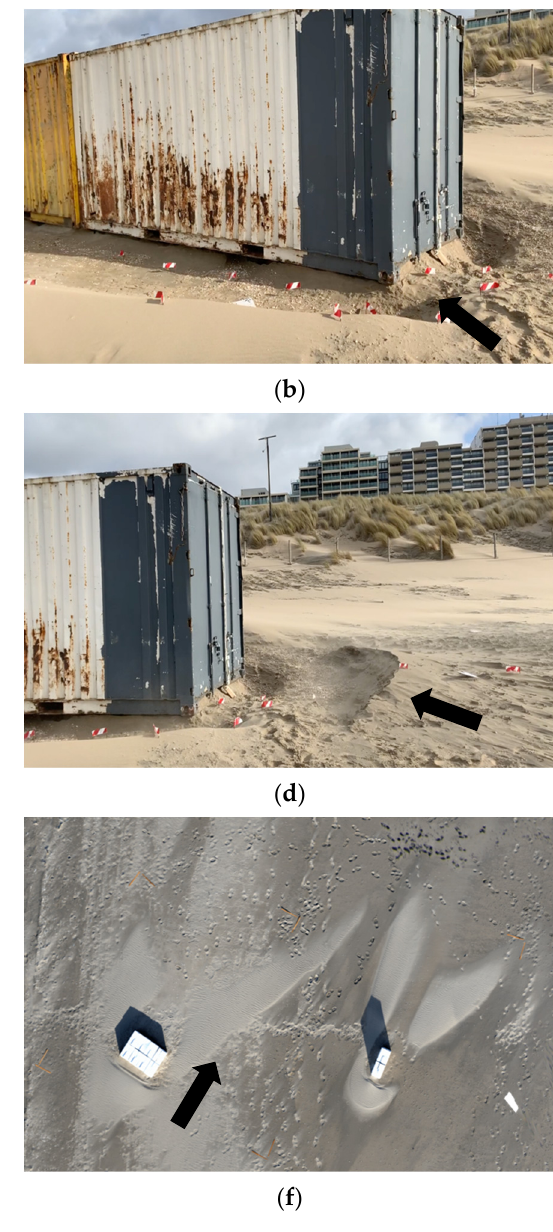
Figure 9. Field observations of erosion and deposition patterns around a ( a – d ) full ‐ scale model at Noordwijk beach, and ( e , f ) small ‐ scale models at De Zandmotor beach, the Netherlands. The arrows show the wind directions. ( c , e , f were obtained from Poppema et al. [18]). As shown by the yellow to red shaded colors in Figure 8 (both small ‐ scale and full ‐